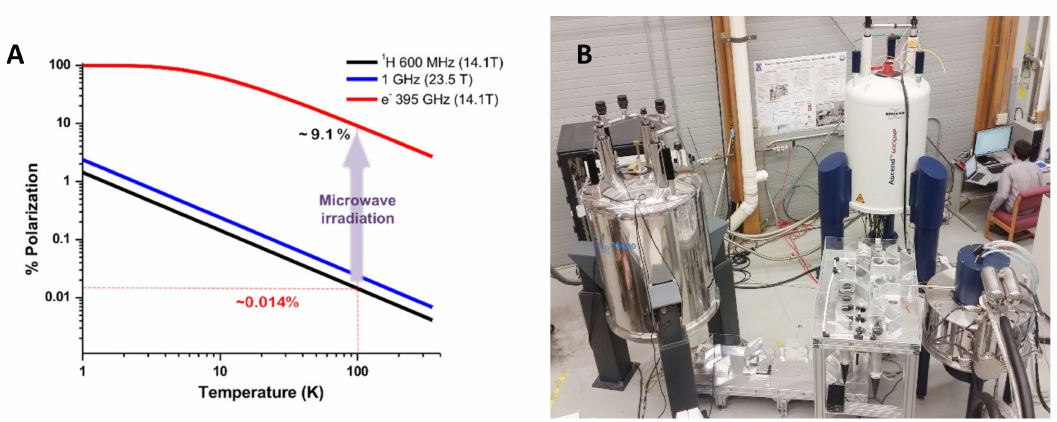
Figure 1. ( A ): Electron and nuclear polarization as a function of temperature and magnetic field. The polarization of an electron (red solid line) and 1 H (black line) at 100 K and 14.1 T are highlighted (red dashed line). The 1 H polarization gain with moving to a higher magnetic field (blue line) is shown for comparison. The general scheme of dynamic nuclear polarization (DNP) is to irradiate at the resonance of an unpaired electron spin (395 GHz at 14.1 T), resulting in the transfer of polarization to nuclear spins, thereby giving DNP enhancement. ( B ): 600 MHz DNP installation at the National High Magnetic Field Laboratory. The magic angle spinning (MAS)-DNP solid-state nuclear magnetic resonance (ssNMR) system is pictured in the upper right corner along with the gyrotron in the lower right corner. The gyrotron supplies high power microwave irradiation to two magnets via the quasioptic tables in the center of the photograph. A complete description of this instrumentation has been published